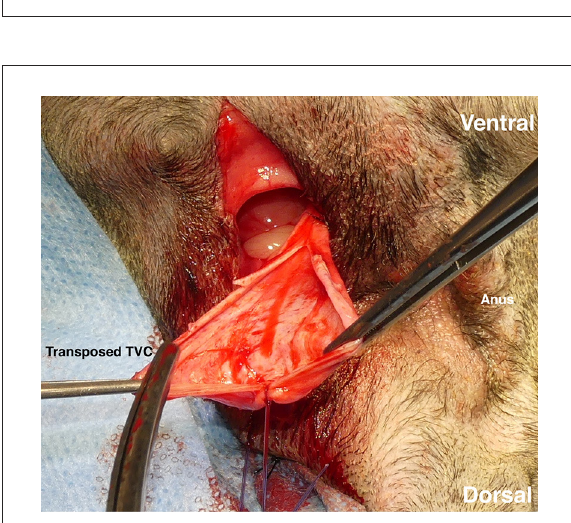
FIGURE4 Tunica vaginalis communis (TVC), which was transposed to the hernial foramen. After confirming the preservation of its blood vessels, a vertical incision was made to expand the TVC into a fan shape.